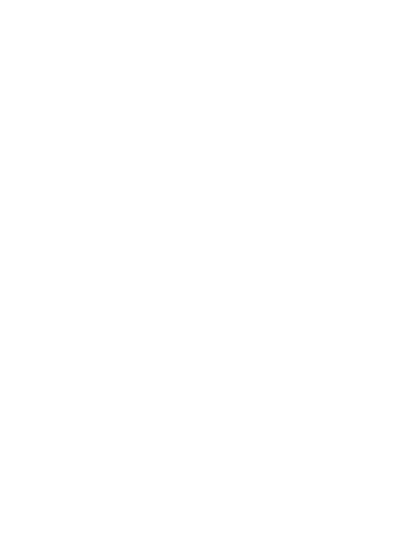
Table 3. The log-likelihood scores and monophyletic